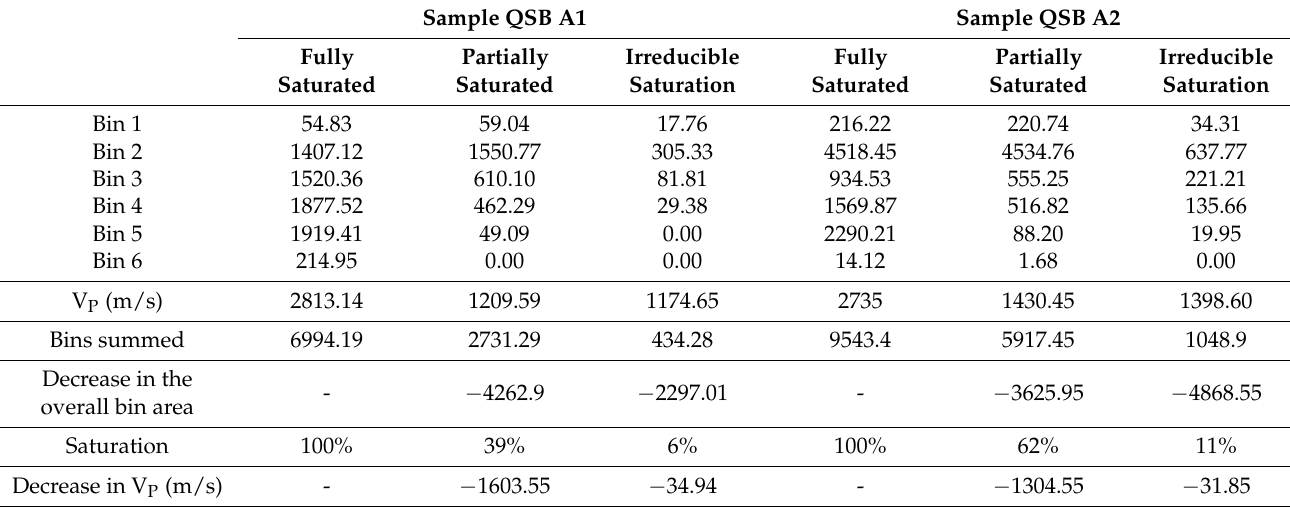
Table 1. The results of the laboratory measurements of the elastic and magnetic resonance responses of the coal samples at three states of fully saturated, partially saturated, and irreducible